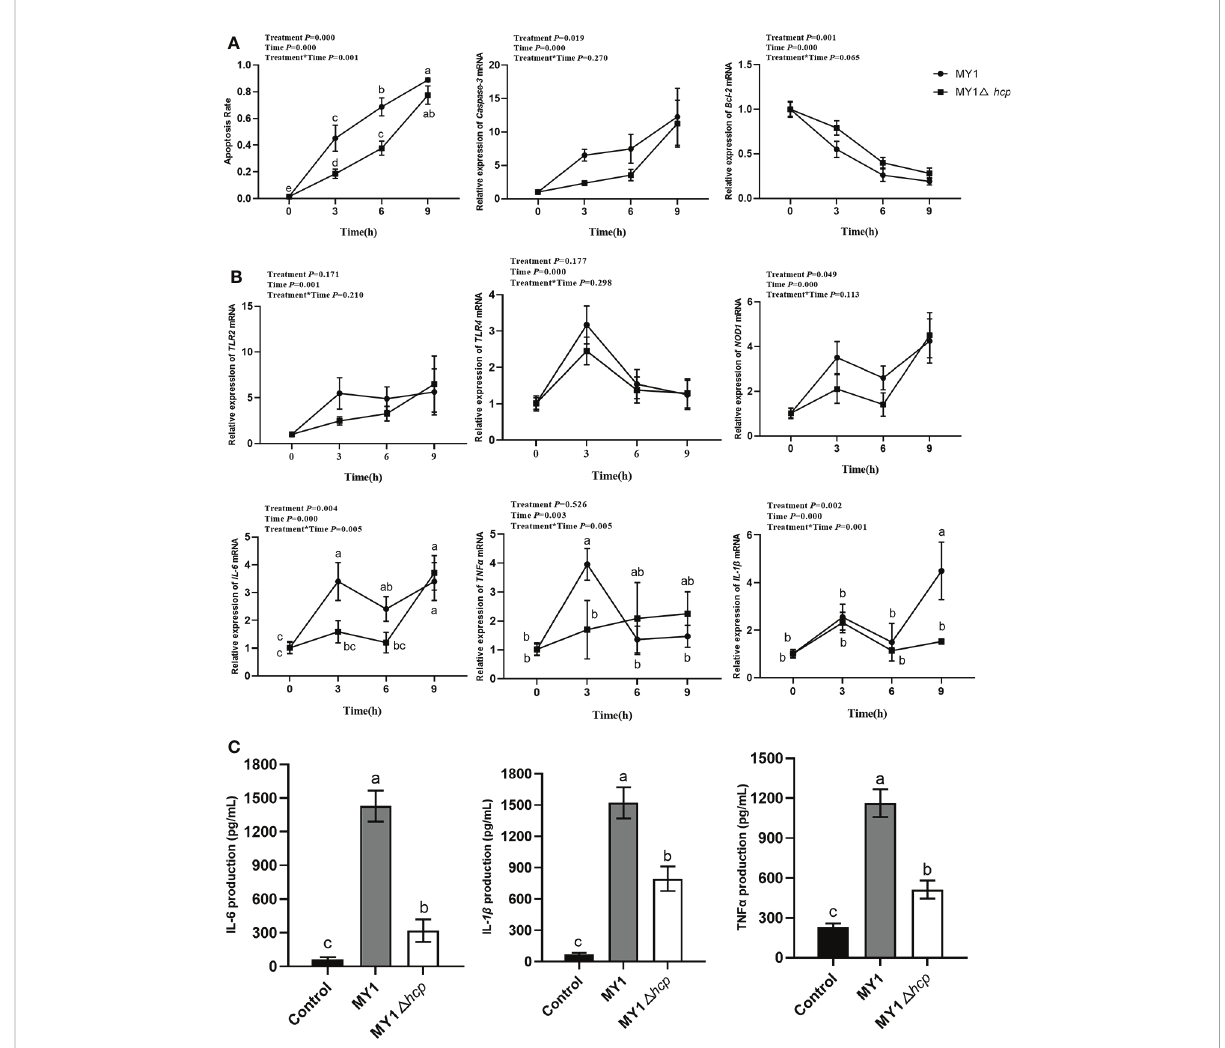
FIGURE 2 The apoptosis and immune response between MY1-infected and MY1 △ hcp -infected dGCs. (A) The dGCs apoptosis rate was detected by Hoechst 33,258 staining and the RT-qRCR results of apoptosis-related gene Caspase-3 and Bcl-2 . (B) The expression of dGCs immune- response genes TLR2 , TLR4 , NOD1 , TNF a , IL-6 , and IL-1 b were detected by RT-qRCR. (C) The release of proin fl ammatory cytokines IL-6, IL-1 b , and TNF- a release of infected dGCs were detected by ELISA. Data acquired from three individual experiments, and each assay was performed by three biological repetitions. The signi fi cant differences were identi fi ed using two-way ANOVA analysis, and the mean values ± SD were shown in each plotting. Different superscripts within columns indicate means are signi fi cantly different ( P <